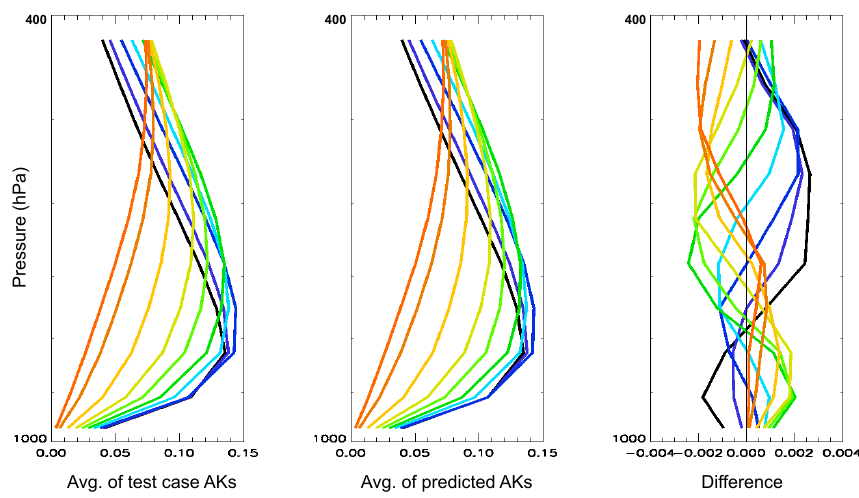
Fig. 14. Same as Fig. 13 but for TES-OMI test Figure 14. Same as Fig. 13 but for TES-OMI test cases.